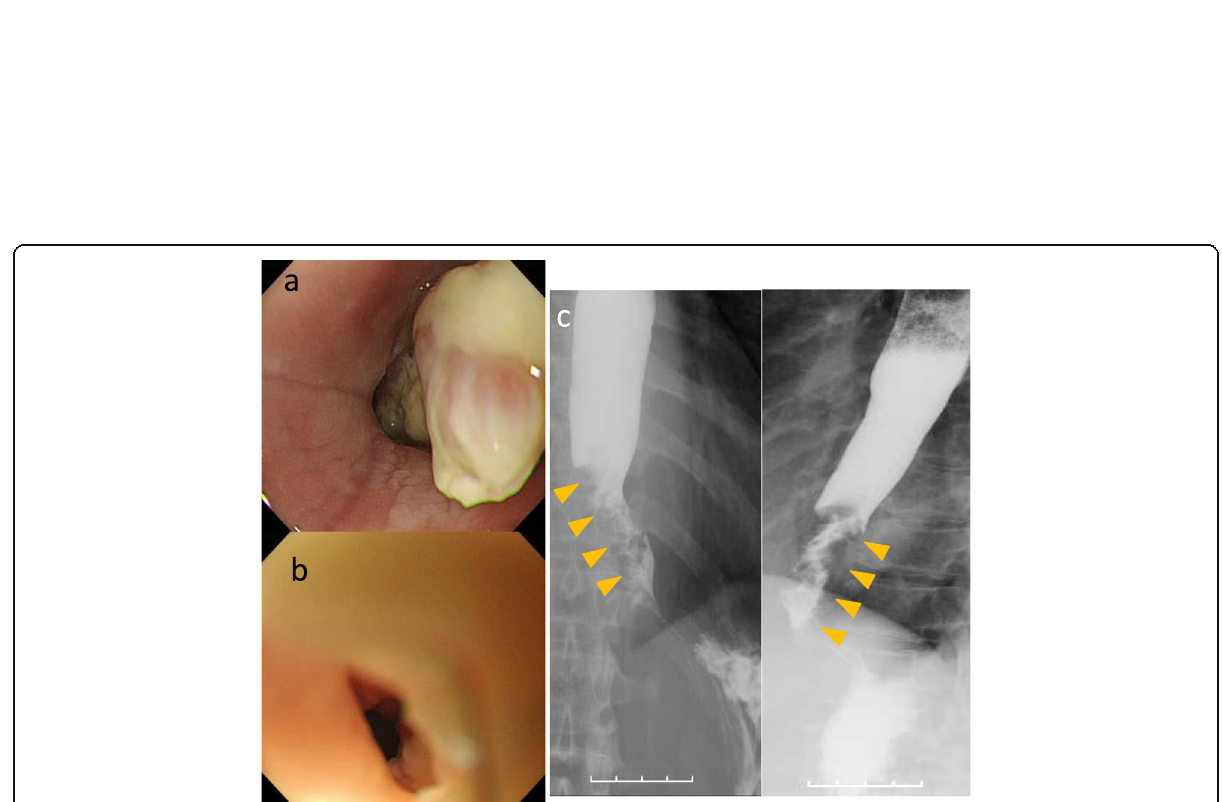
Fig. 4 Endoscopic examination and esophagography 1 year and 6 months later. a , b Polypoid lesions increased further, and the biopsy specimen was diagnosed as neoplasia. c Esophagography revealed the irregular stenosis at the lower esophagus (arrow